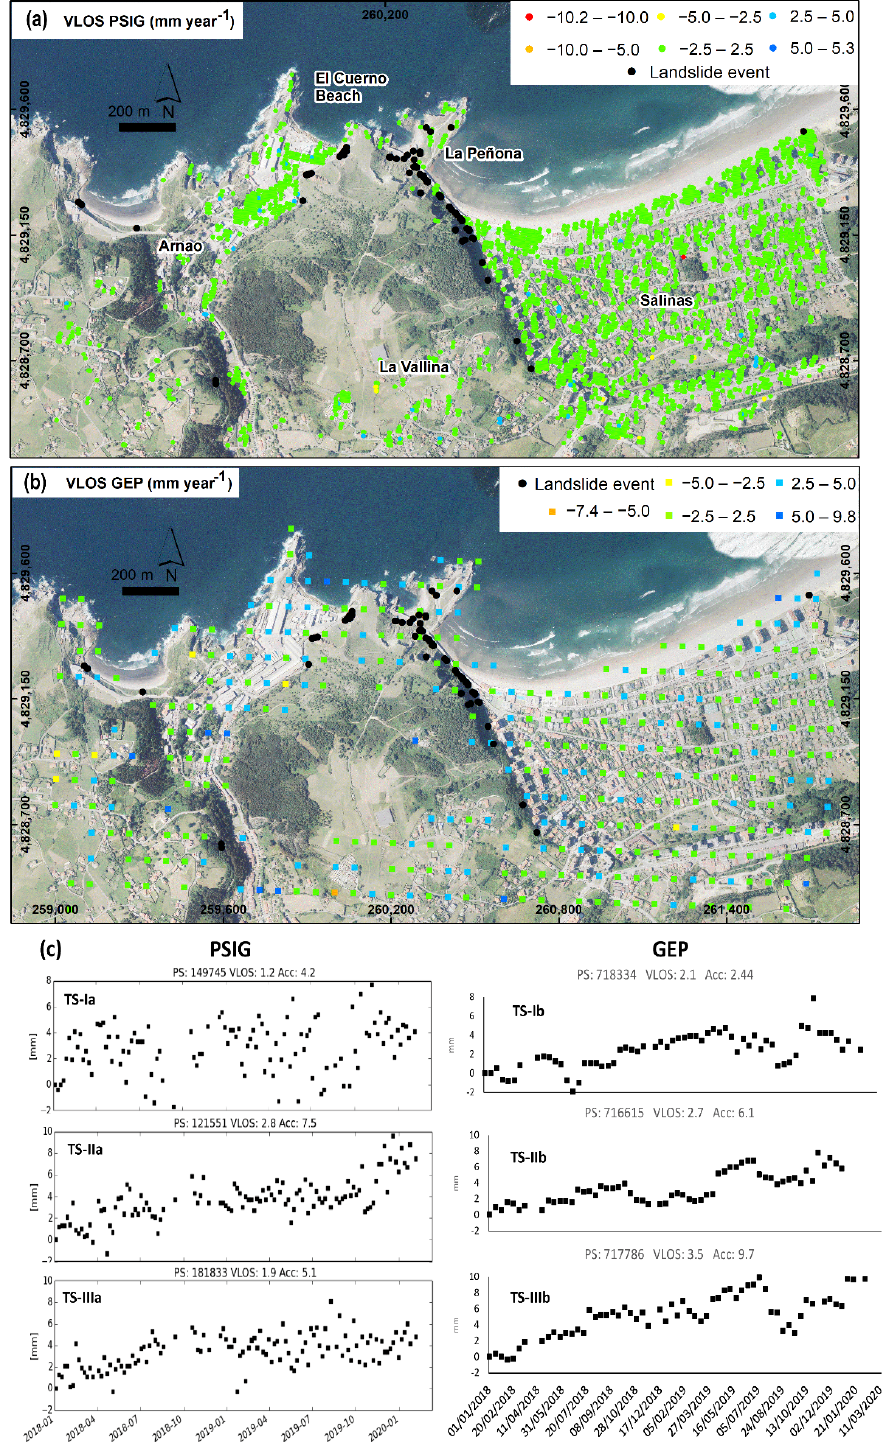
Figure 7. Salinas town. ( a ) LOS mean deformation velocity map by PSIG chain; ( b ) LOS mean deformation velocity map by GEP service; ( c ) Deformation time series obtained by PSIG and GEP. OrtoPNOA 2017 CC-BY 4.0 scne.es.